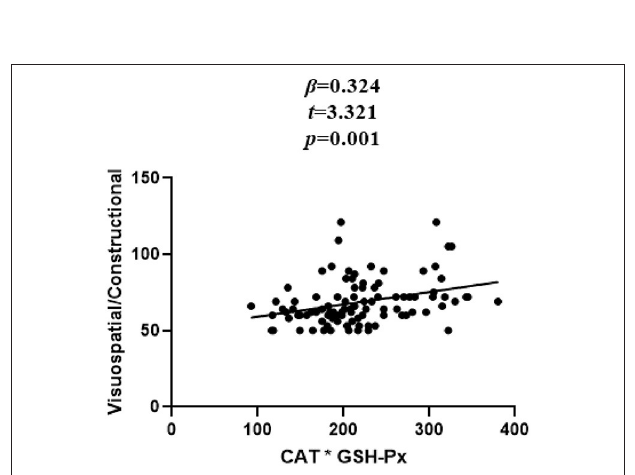
FIGURE 2 | Correlation between plasma CAT * GSH-Px and Visuospatial/Constructional score in chronic schizophrenia patients.